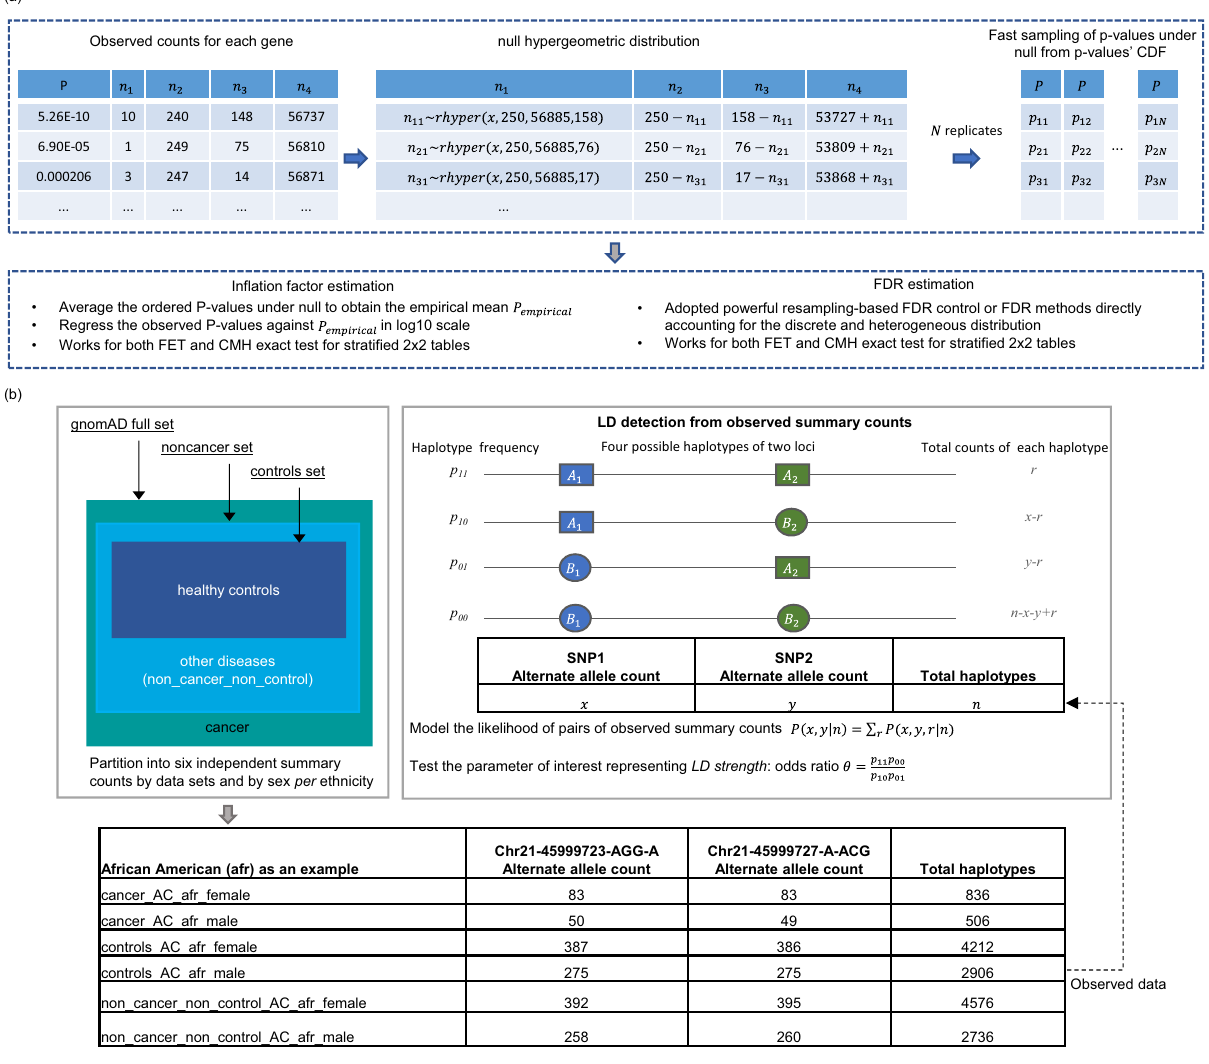
Fig. 2 The schematic representation of proposed methods in CoCoRV. a The estimation of in fl ation factors and FDR. We sample the raw P values under the null directly from P value ’ s cumulative distribution function (CDF) which is very fast. Either Fisher ’ s exact test or Cochran – Mantel – Haenszel exact test can be used. Either one-sided or two-sided test can be speci fi ed. b LD detection using gnomAD summary counts. The gnomAD full data sets were partitioned into three independent sets of summary counts and then further partitioned into six independent sets strati fi ed by sex. The six independent summary counts between a pair of variants can be modeled with the LD strength as a parameter, and the LD strength can be tested for LD detection. The table at the bottom shows an example of the six independent summary counts between two variants of high LD in the African American ethnicity